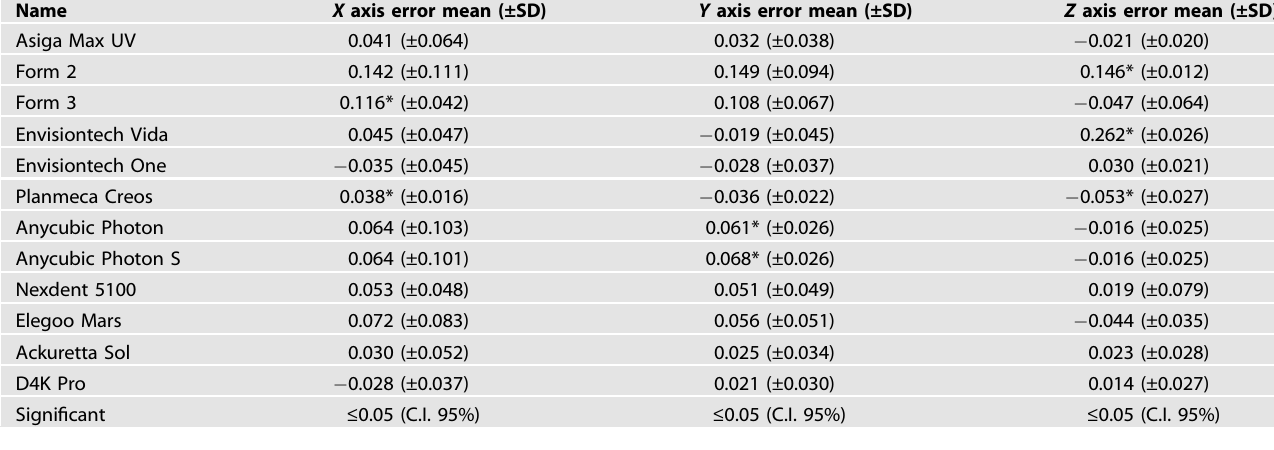
Table 2. Mean deviation of each printer in comparison to the master STL.